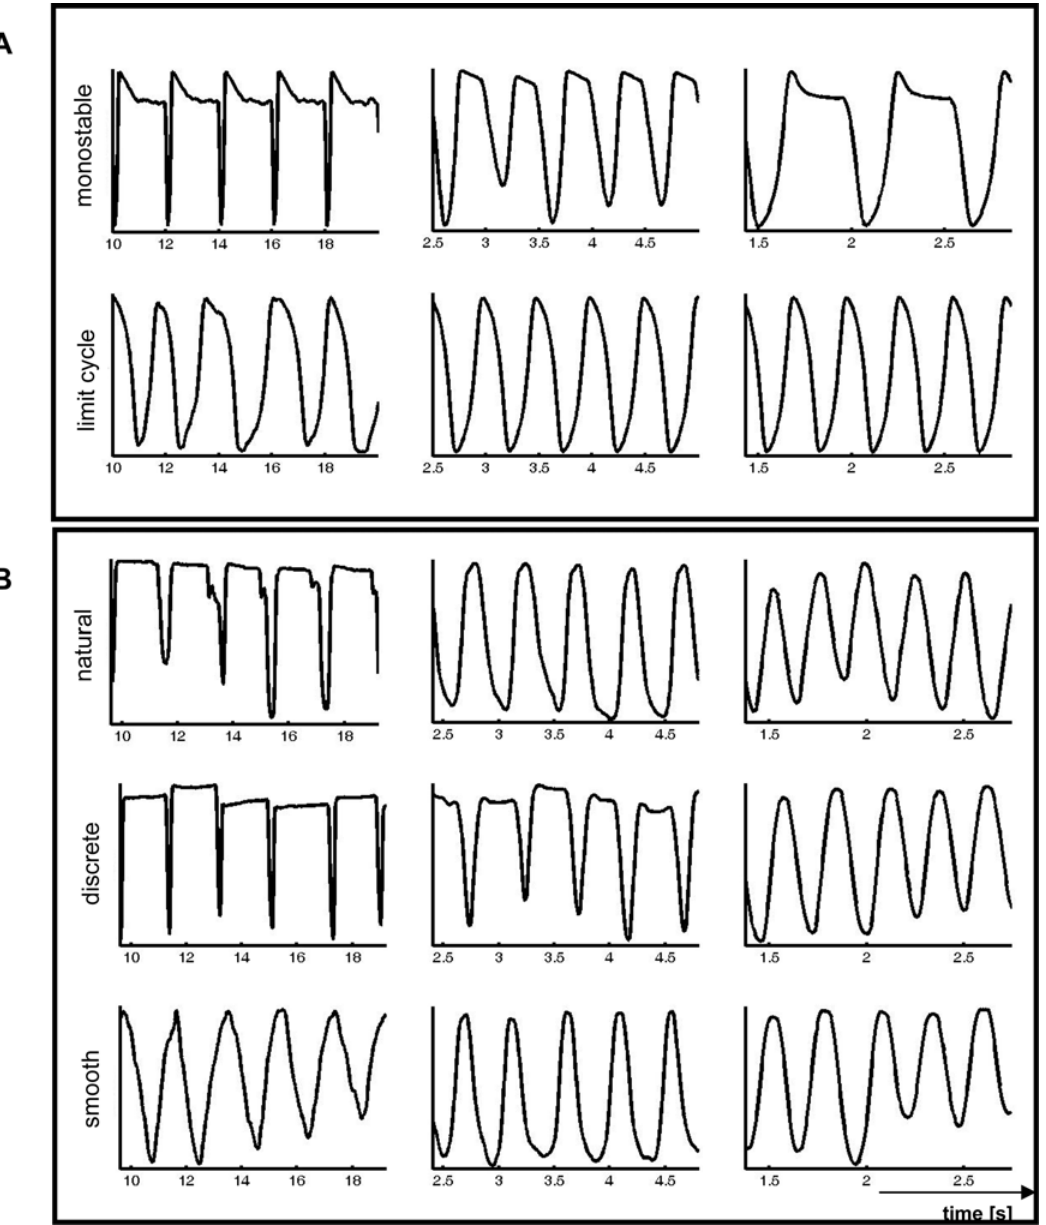
Figure 2. Representative time-series. Time [s] is represented on the horizontal axes; (normalized) position on the vertical axes (not depicted in the Figure). (A) Model simulations in the mono-stable (upper panel) and limit cycle regime (lower panel) at 0.5 Hz, 2.0 Hz, and 3.5 Hz (left, middle, and right column, respectively). (B) Data of one participant in the natural, discrete, and smooth condition (upper, middle, and lower row, respectively) at 0.5 Hz, 2.0 Hz, and 3.5 Hz (left, middle, and right column, respectively). Note the qualitative correspondence with the mono-stable regime in the discrete and natural condition at slow movement paces and with the limit cycle regime in all conditions at high paces.